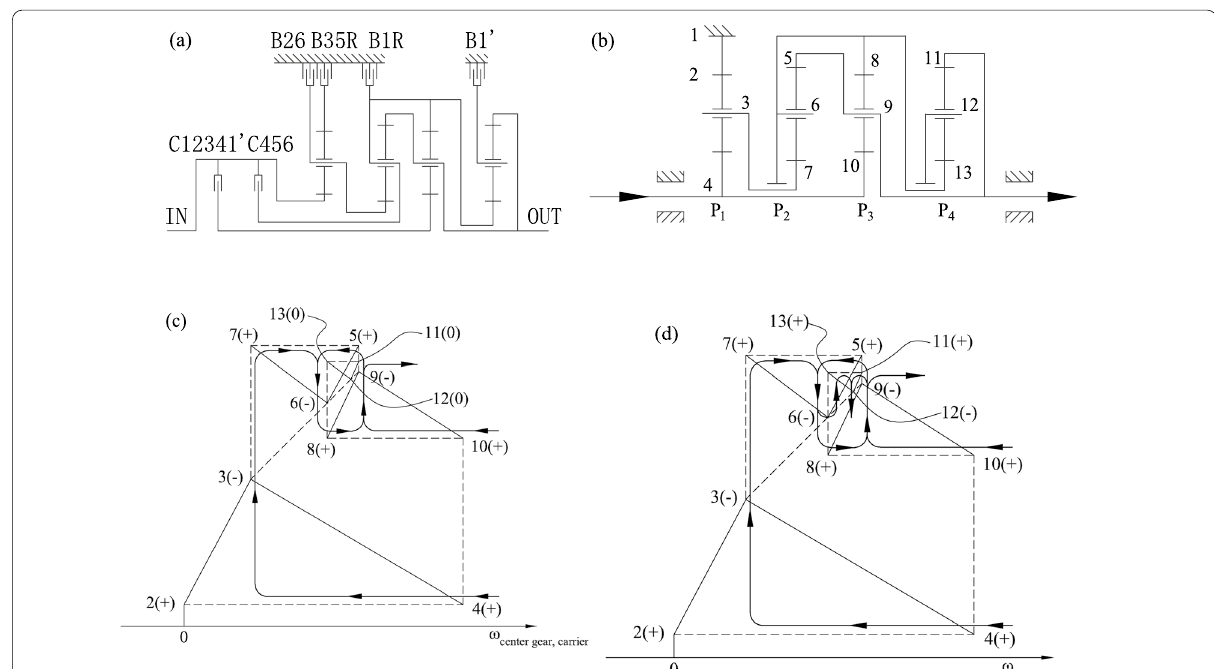
Figure 9 Four‑stage parallel‑connected transmission and its gear III: ( a ) Transmission diagram, ( b ) gear train in gear III, ( c ) power flow in gear III, ( d ) power flow with two